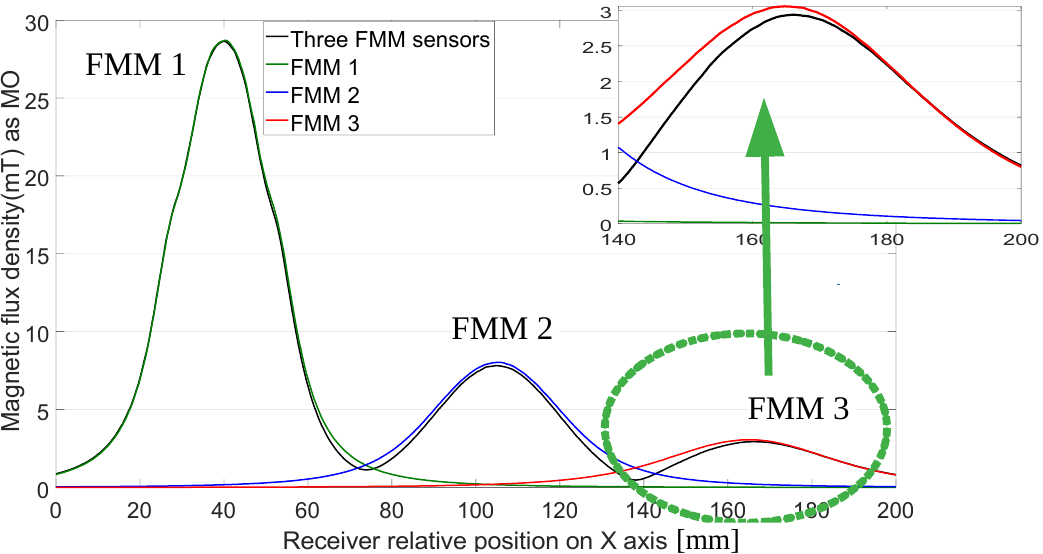
Figure 11. Numerical model of Configuration 2: MO for each FMM tool independently vs. MO from all three tools with reactive-part dimensions of 25 mm × 25 mm × 1 mm.